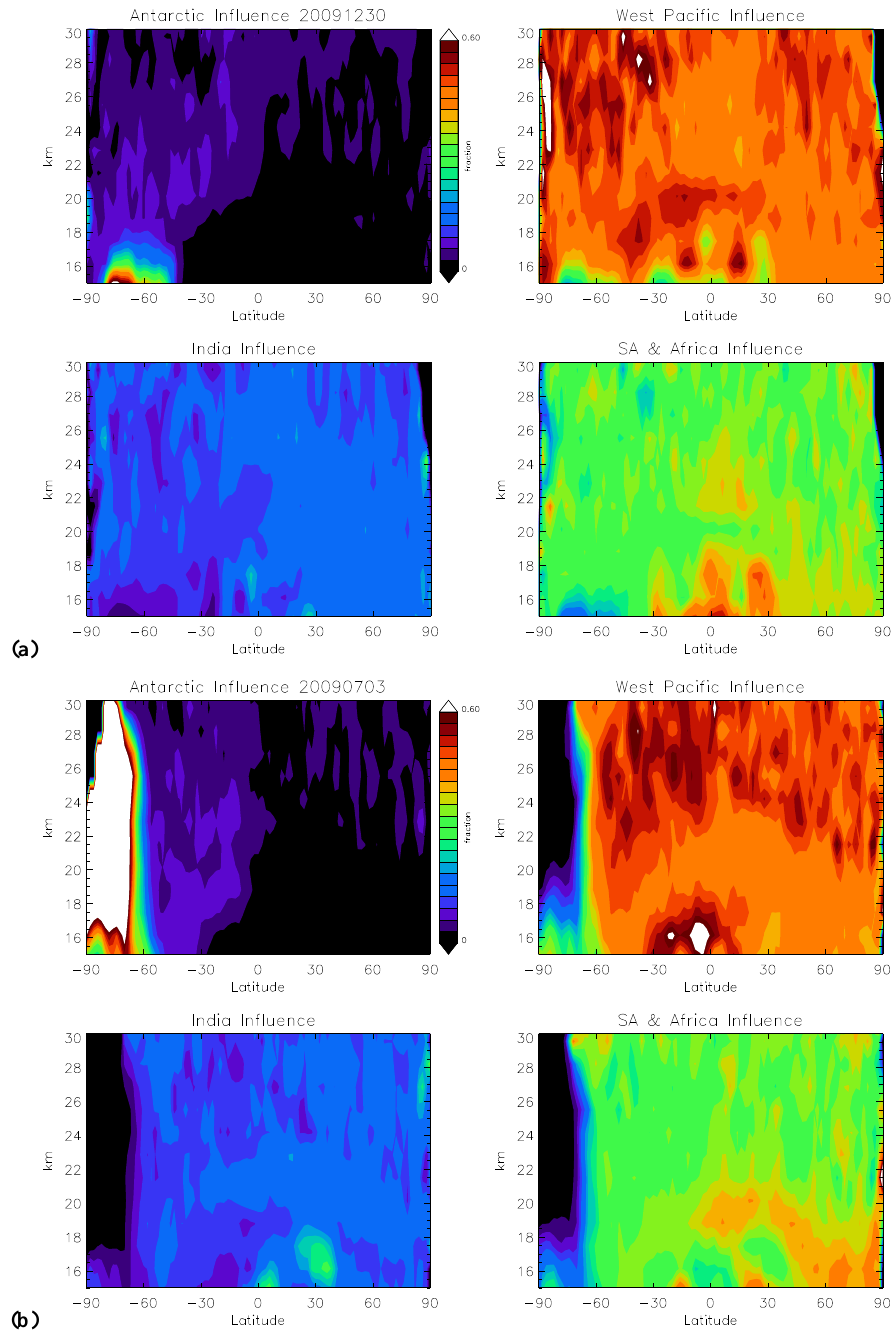
Fig. 10. Gridded instantaneous fractional distribution of parcels that dehydrated in different locations for 31 December 2009 (a) and 3 July 2009 (b) , D100, or influence. Figure 8a shows the region map